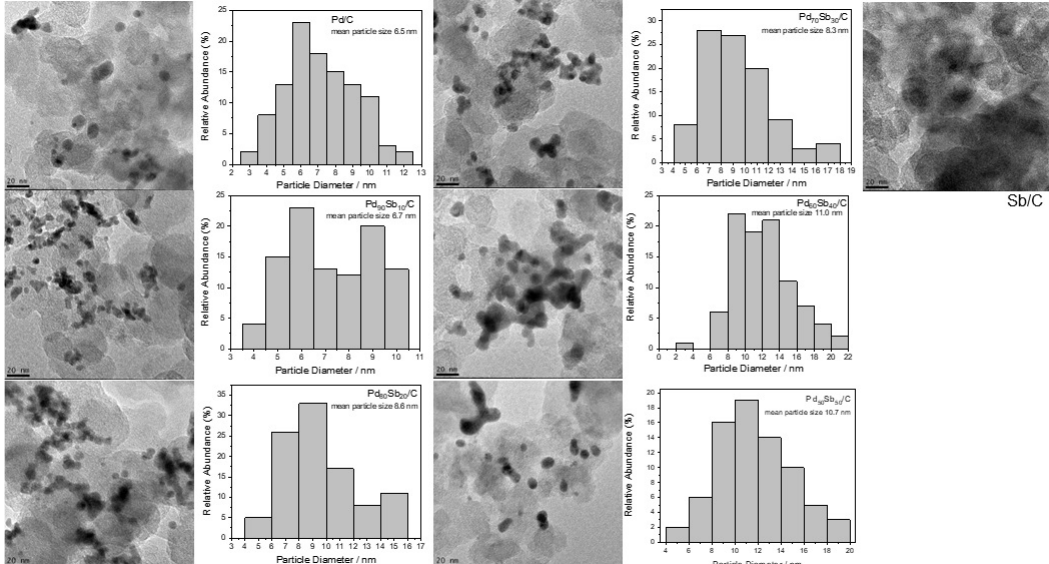
Figure 2. Micrographs obtained by TEM and distribution histograms of PdSb/C materials in different compositions.